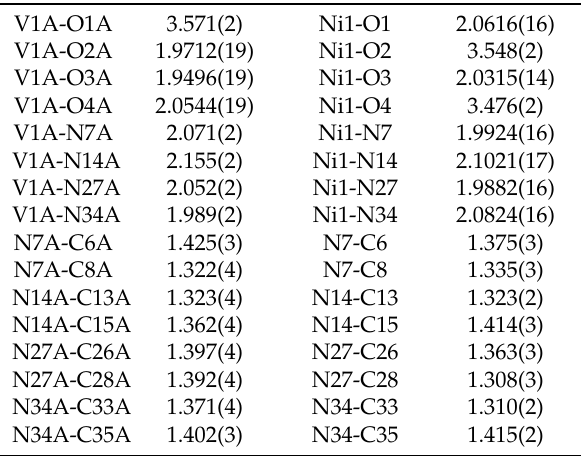
Figure 2. The crystal structures of [V(L sq1 )(HL ox )] and [Ni(HL ox ) 2 ] with the intramolecular hydrogen bonds drawn with dashed lines. The C–H hydrogen atoms and tert -butyl groups are omitted for clarity. Thermal ellipsoids are drawn at the 30% probability level. Table 2. Selected bond lengths (Å) for [V(L sq1 )(HL ox )] and [Ni(HL ox )2].